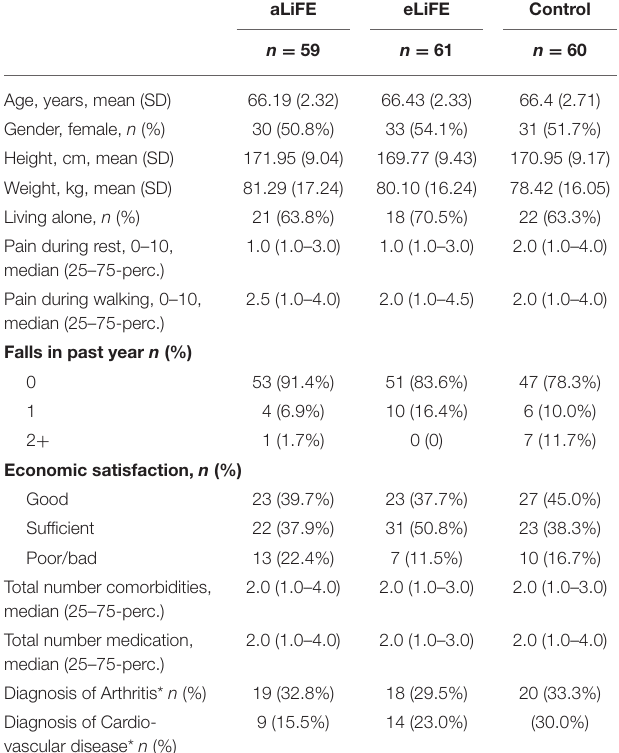
TABLE 1 | Participant characteristics.